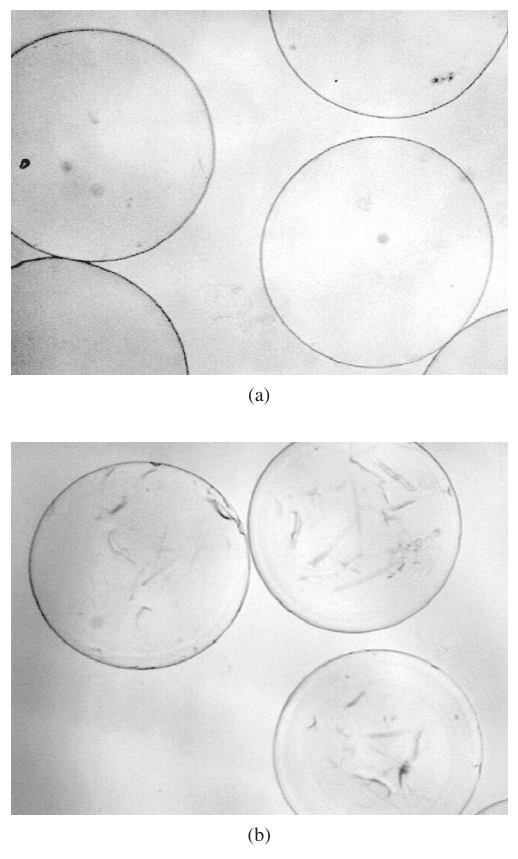
Figure 4. Comparative evaluation, under phase contrast microscopy, of empty microcapsules produced with Biodritin ® in 20 mM CaCl Pre-implant observation and after four weeks of subcutaneous implant in Wistar